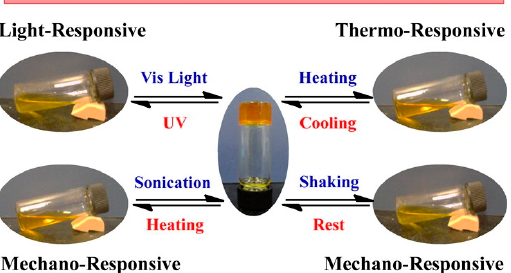
Figure 1. Gel–sol and sol–gel transitions of an organogel in 2-methoxyethanol. Image adapted with permission from reference [10]. Copyright 2012 American Chemical Society.